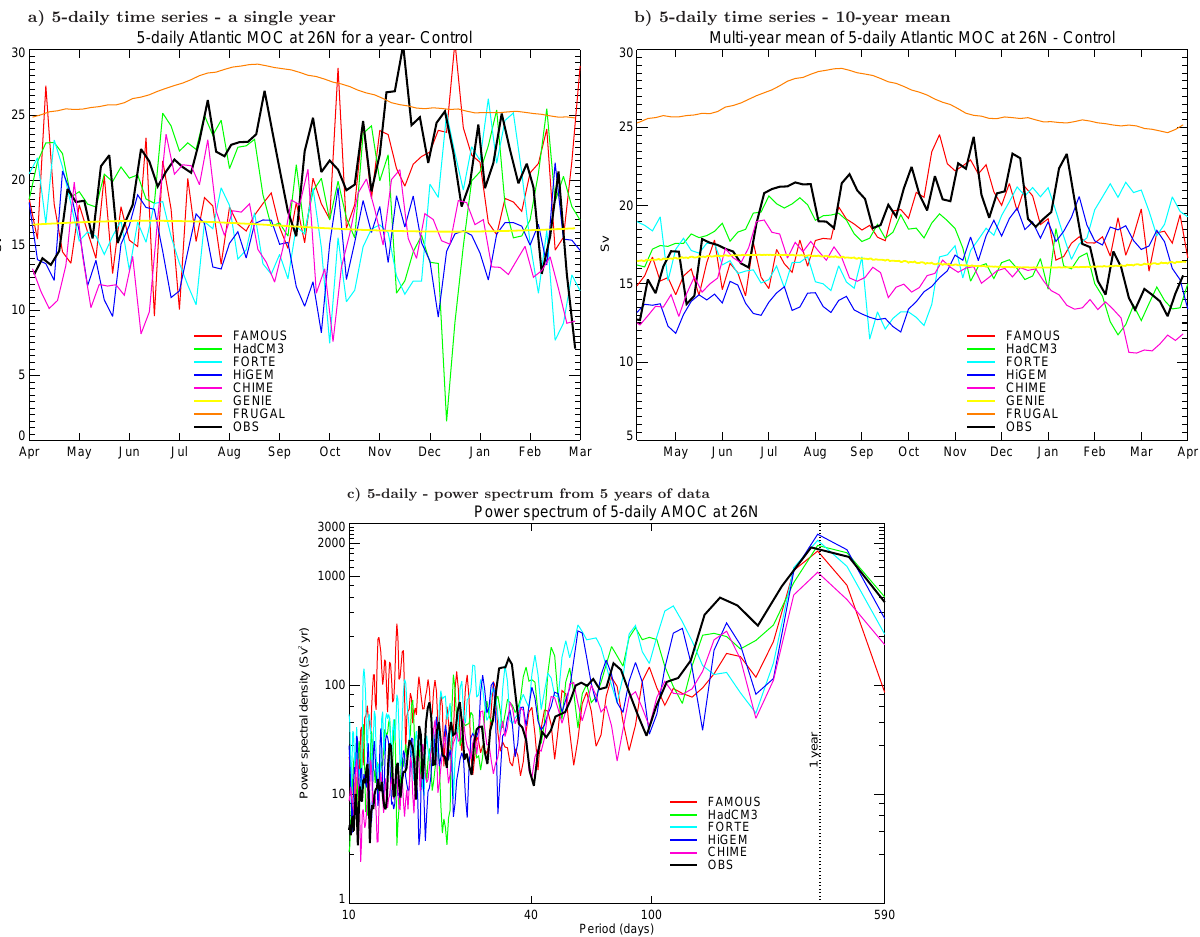
Fig. 1. Atlantic MOC ( T over ) at 26 ◦ N (a) 5-daily time series – for a single year (the second year of the model integrations and observations) (b) 5-daily time series – 10-yr mean in models and 5-yr mean in observations (The FRUGAL transport is calculated along a curvilinear gridline which is near 26 ◦ N. For GENIE, time-step data is plotted; its ocean time-step is 3.65days) and (c) 5-daily – power spectrum (Note the logarithmic scale on the y-axis. Oscillations of less than 40-day period are significant in observations and in all the models, except FRUGAL and GENIE).